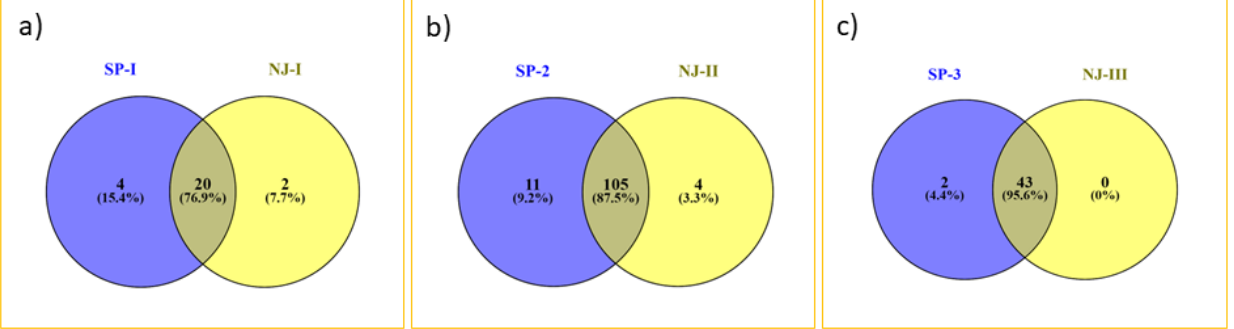
Figure 4. Venn diagrams depicting comparison of grouping patterns generated by STRUCTURE and neighbor ‐ joining tree. SP1 = Gaur and Tho ‐ tho samples; SP2 = Arunachal and Nagaland mithun samples; SP3 = Manipur and Mizoram mithun samples. ( a ) Venn diagram showing co ‐ linearity between model ‐ based sub ‐ population SP1 & neighbor ‐ joining based cluster 1. ( b ) Venn diagram showing co ‐ linearity between model ‐ based subpopulation SP2 & neighbor ‐ joining based cluster 2. ( c ) Venn diagram showing co ‐ linearity between model ‐ based subpopulation SP3 & neighbor ‐ joining based cluster 3.